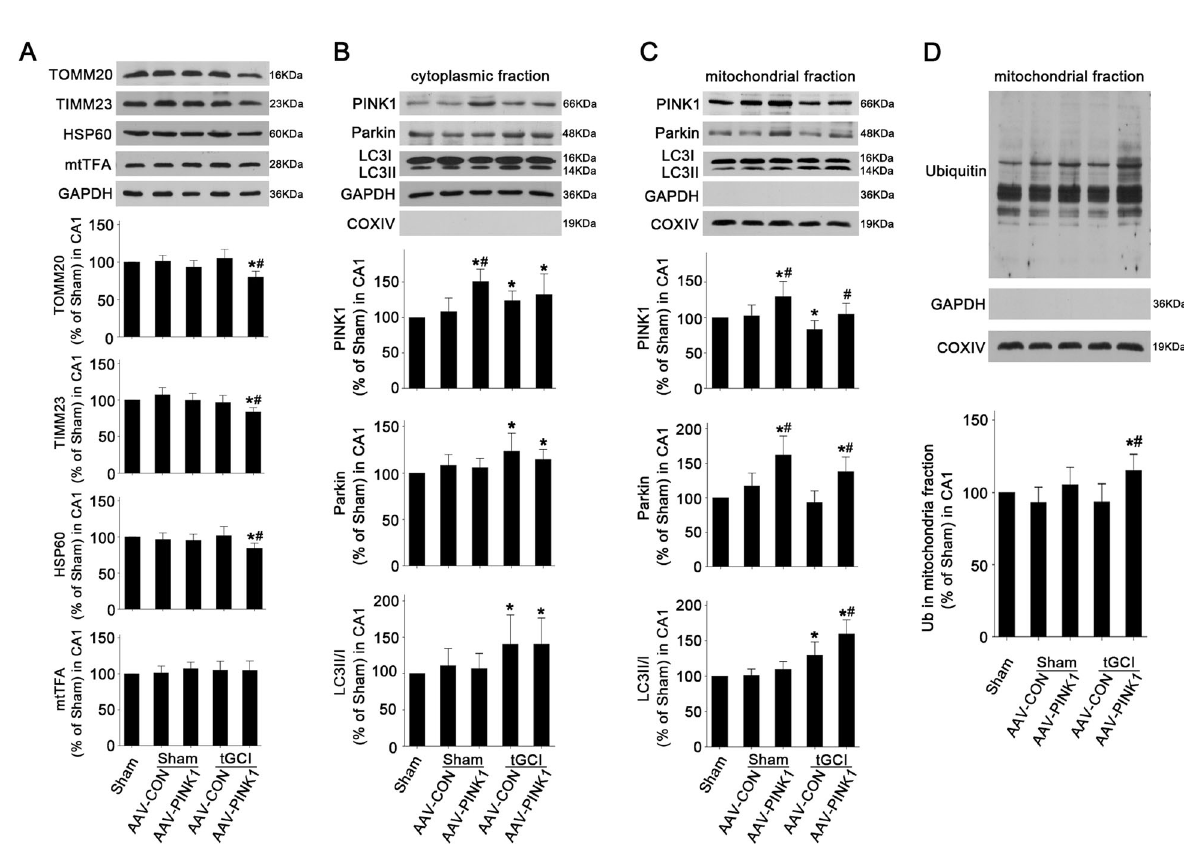
Fig. 6 Effects of AAV-PINK1 administration on mitochondrial ubiquitination and mitochondrial clearance in CA1 after ischemia. A Western blot analyses of TOMM20, TIMM23, HSP60 and mtTFA in CA1. The histogram presents the quantitative analyses of TOMM20, TIMM23, HSP60, and mtTFA levels. Western blot analyses of PINK1, Parkin, and LC3 in the cytoplasmic fraction ( B ) and mitochondrial fraction ( C ) of CA1. The histogram presents the quantitative analyses of PINK1, Parkin, and the ratio of LC3-II/I. D Western blot analysis of ubiquitin in the mitochondrial fraction of CA1. The histogram presents the quantitative analysis of ubiquitin levels. Data are expressed as percentage of value of Sham animals. Each bar represents the mean ± SD. * p < 0.05 vs. Sham group and # p < 0.05 vs. the same group with AAV-CON injection ( n ≥ 4 in each